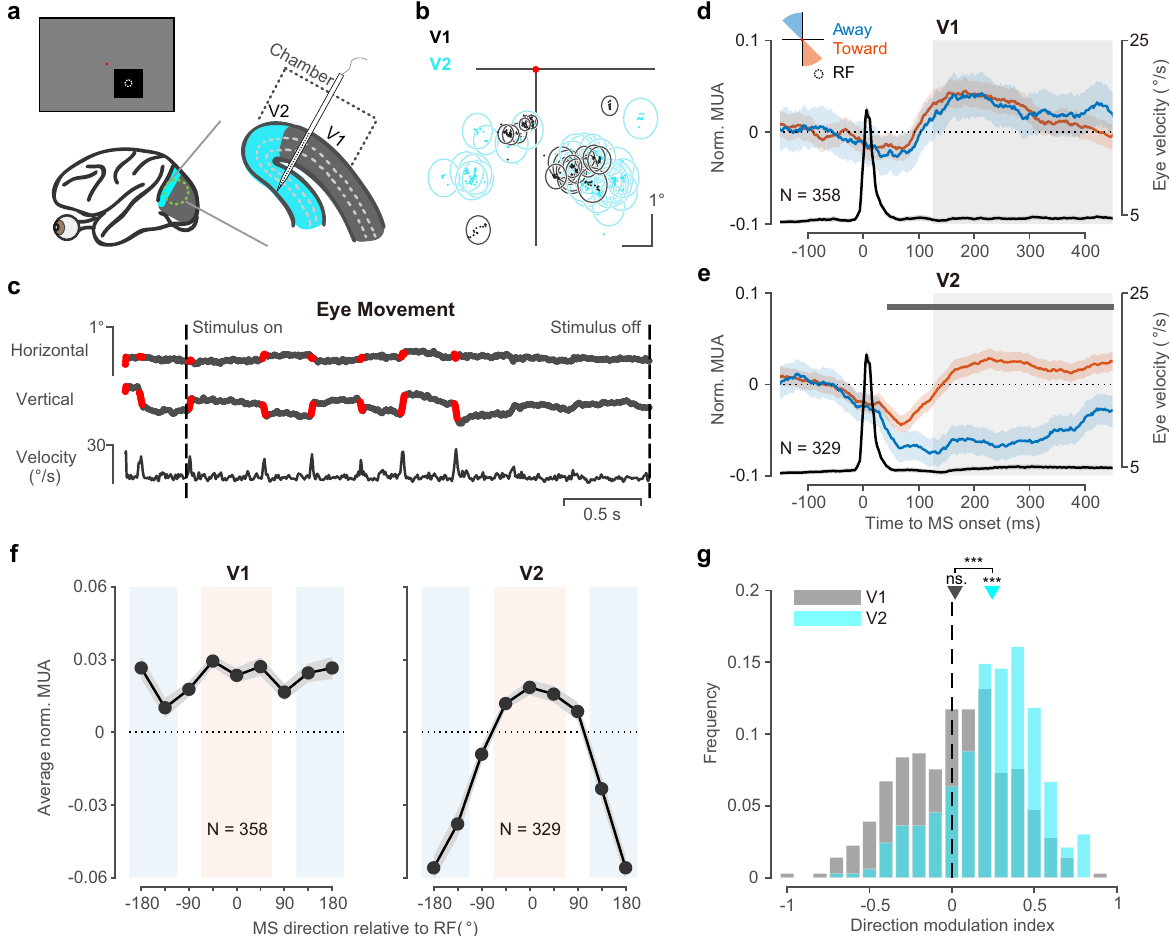
Fig. 1 | Direction-speci fi c microsaccade modulation in V2 but not in V1. a A uniformsquarestimuluswithitscenterlocatedattheRFsoftherecordingsiteswas usedinthe fi xationtask.Thespikingactivityandlocal fi eldpotentialwererecorded with a V-probe (Plexon, 24 channels, interchannel spacing 100 μ m). In each recording session, the linear probe was inserted perpendicularly into V1 (gray region) or V2 (cyan region, underneath V1) to record neurons from all layers. b SpatialdistributionsforRFcenters(dots)ofrecordedunitsfromallsessions.The circles represent the mean location (center) and size (radius) of the RFs from each session. c The horizontal and vertical eye-movement locations from one example trialwererecorded byaninfrared camera.The identi fi ed microsaccade-generation periods are marked in red. The vertical dashed lines indicate the onset ( t =0s) or offset( t =3s)ofthestimulus. d NormalizedMUA(mean±s.e.,orangeandbluelines intheleftverticalaxis)inV1andaveragedvelocityofeyemovement(theblackline in the right vertical axis) around microsaccade (MS) onset. Microsaccades were